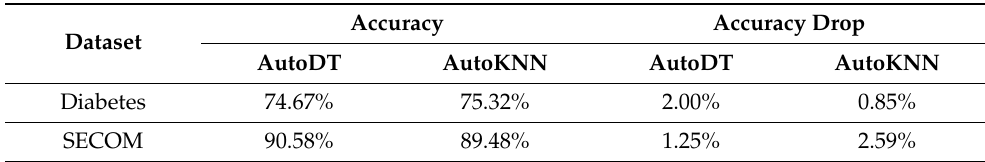
Table 11. “One-shot” AEP performance accuracy (and accuracy drop with respect to the full AEP system) on the NUCLEO-H743ZI2